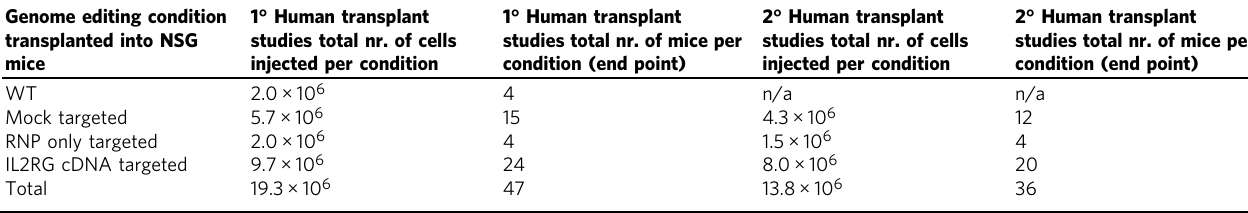
Table 2 IL2RG cDNA genome targeted frequencies pre- and pos-t transplant Time of genome editing quanti fi cation (ddPCR)